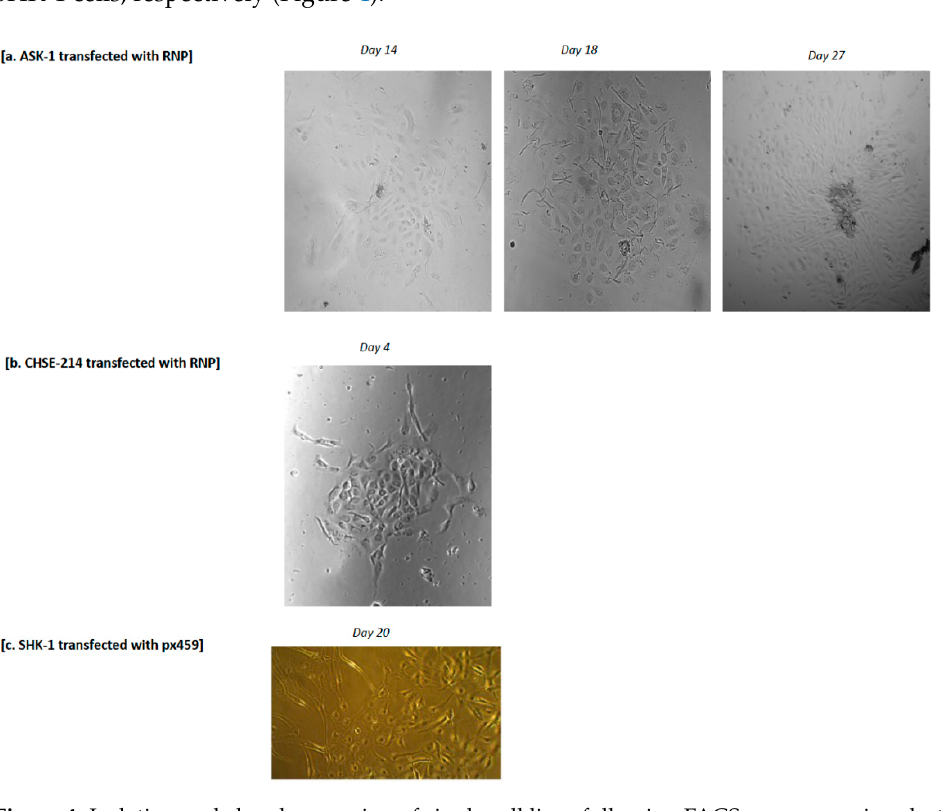
Figure 4. Isolation and clonal expansion of single cell lines following FACS or puromycin selection of positively transfected cells. ( a ) Micrographs of FACS-isolated single cell-derived clonal ASK-1 cell line at day 14, day 18 and day 27 following FACS (magnification 20× for day 14 and day 18; 5× for day 27); ( b ) micrograph of FACS-isolated single cell-derived clonal CHSE-214 cell line at day 4 after FACS (magnification 10×); ( c ) micrograph of puromycin-selected SHK-1 cells at day 20 after puromycin treatment (magnification 10×).